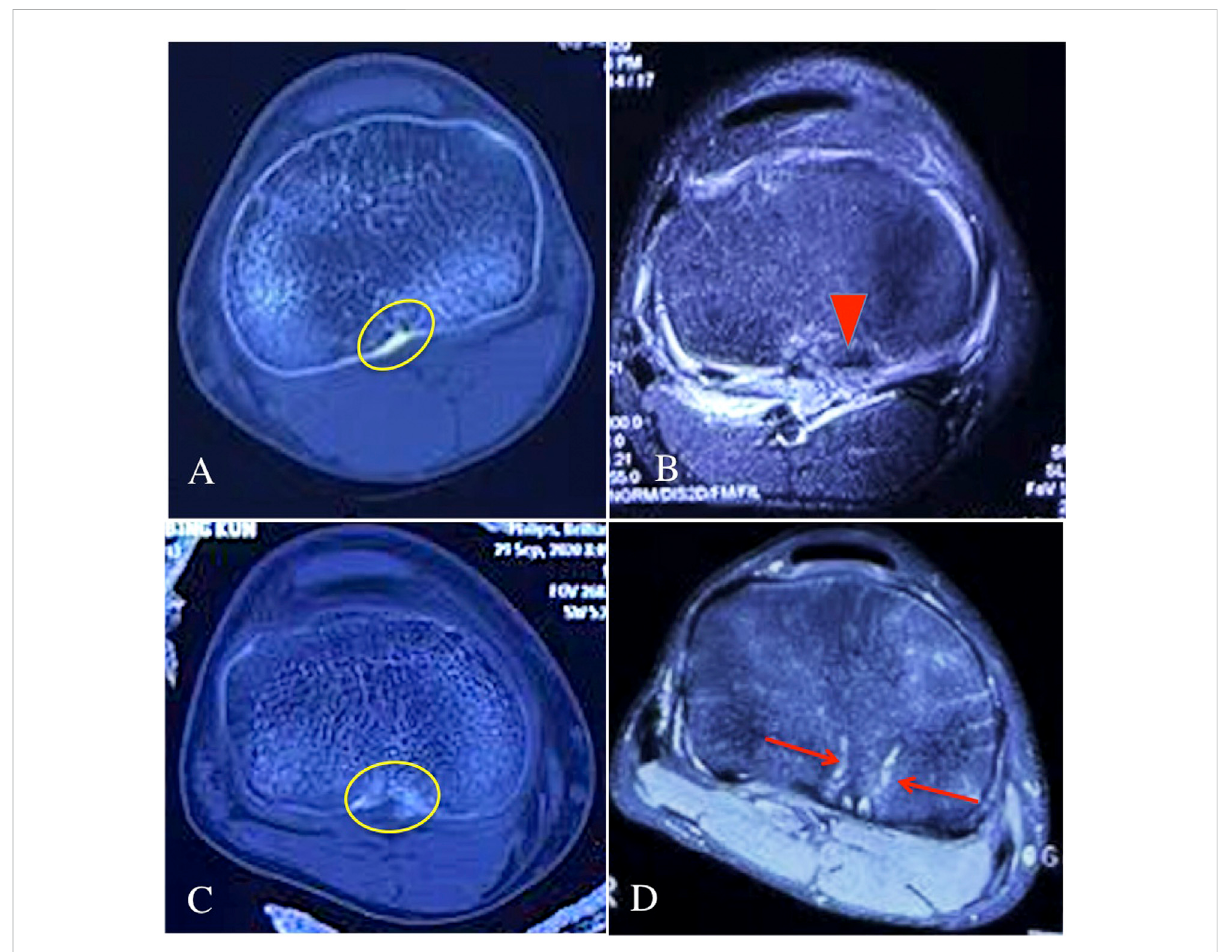
FIGURE 2 The CT scan and knee MRI of the two groups during the follow-ups. (A) knee CT scan of the bio-absorbable group at 3 months follow-up, the yellow circle showed a well bone union of the PCLAF in post-operation; (B) knee MRI of the bio-absorbable group at 1 year follow-up, the red triangleshowedan intactPCLwiththenormalsignal; (C) kneeCTscanofthesuturepull-outgroupat3 monthsfollow-up,theyellowcircleshowed a well bone union of the PCLAF in post-operation; (D) knee MRI of the suture pull-out group at 1 year follow-up, the red arrows showed the trans-tibial tunnels still existed.